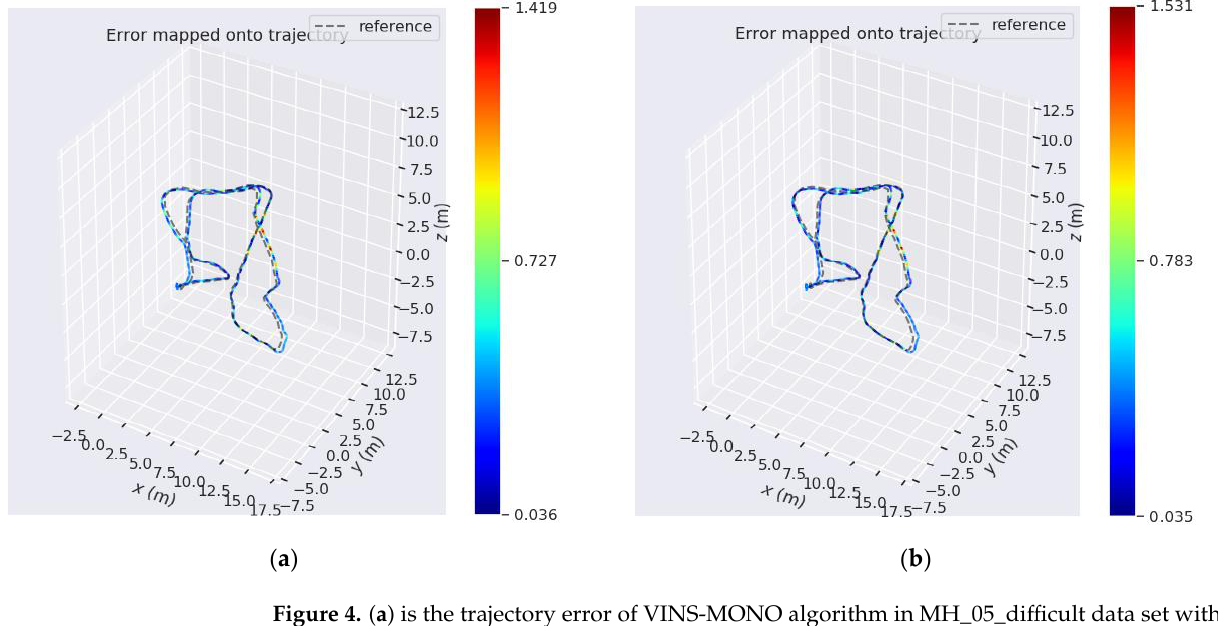
Figure 4. ( a ) is the trajectory error of VINS-MONO algorithm in MH_05_difficult data set without loopback detection. ( b ) is the trajectory error of the optimized VINS-MONO without loopback detection on MH_05_difficult data set. (The unit of scale is m).